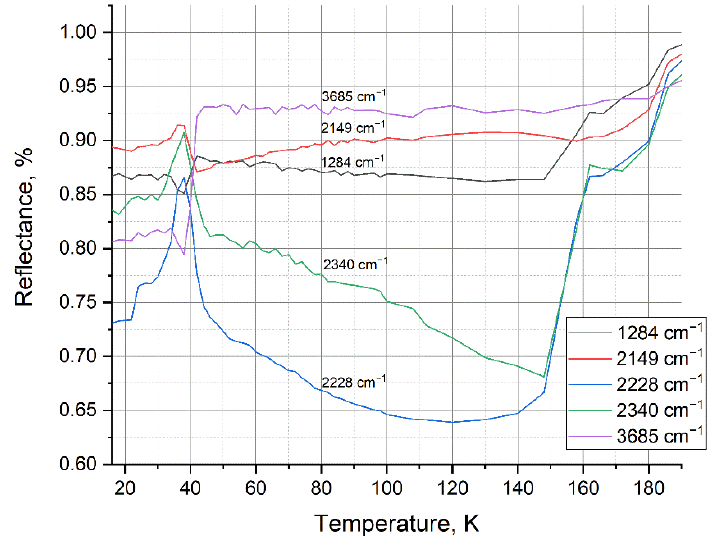
Figure 9. Thermogram for a mixture of water with argon condensed at 16 K.